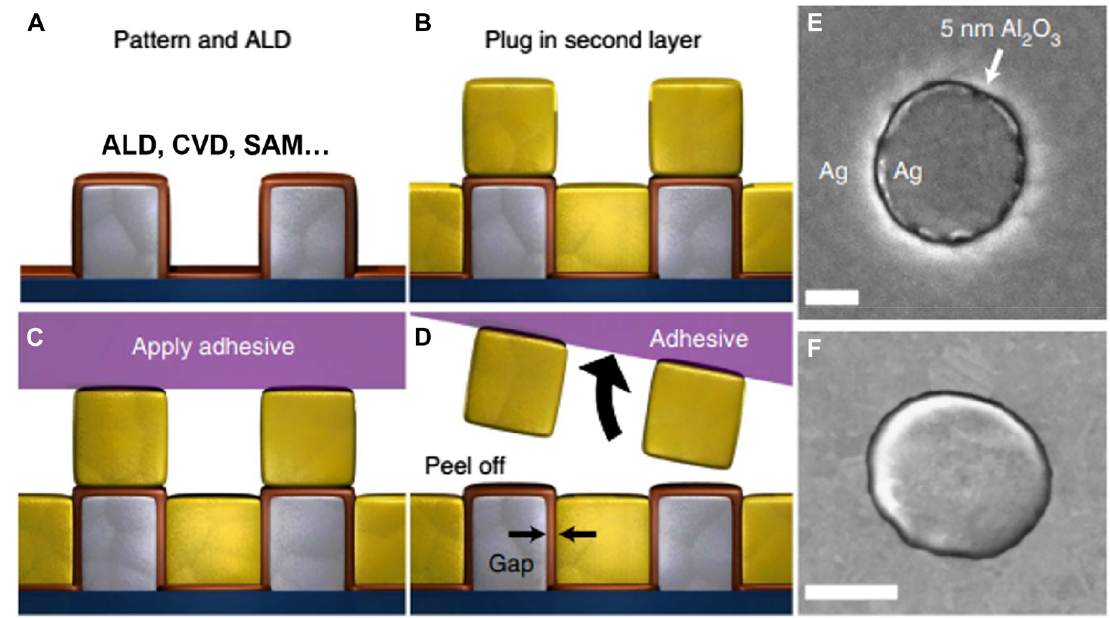
Figure 11: Nanogap fabrication with atomic layer lithography. (A) First metallic pattern is conformally coated with a dielectric layer with either atomic layer deposition (ALD), chemical vapor deposition (CVD), or self-assembled monolayer (SAM). (B) Second layer of metal is deposited on top of the whole sample, filling the empty space, and defining in-plane-stacked metal – insulator – metal structure. (C) and (D) Applying adhesive and peeling off the overhanging metal layer planarizesthesampleandrevealsthegap.(E)and(F)TopviewSEMimagesoffabricatedgapstructures,whosegapwidthisdeterminedbythe thickness of deposited dielectric layer. Scale bar: 300 nm (E) and (F). Reproduced with permission from